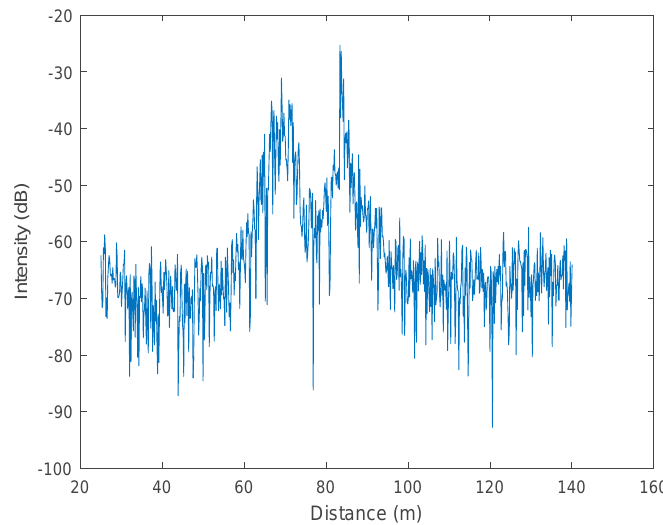
Figure 5. Single radar profile at the Evo site. The ground was 84 m and the tree-canopy backscatter ranged from 63 to 73 m from the radar. The signals from the canopy and the ground were approximately 30 dB above noise.